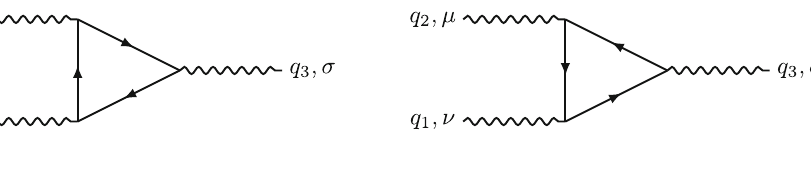
Fig. 5 Feynman diagrams for the γγγ vertex at